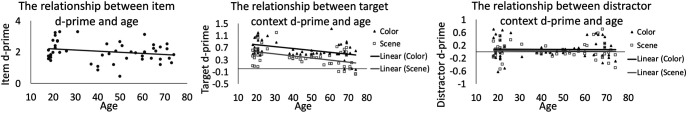
Item, color, and scene context memory discriminability.